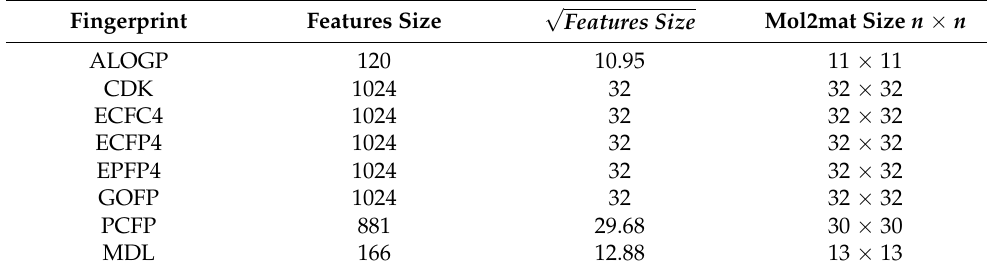
Table 8. Details of every matrix size for every